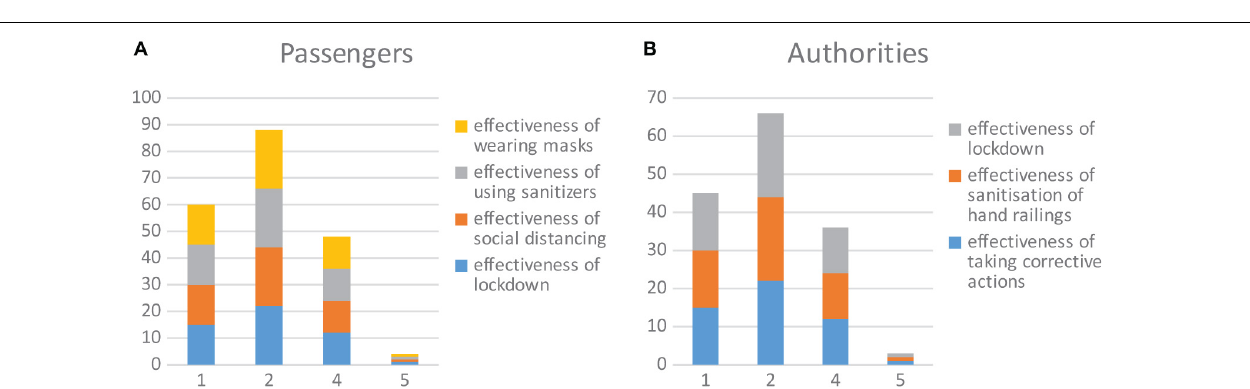
Frontiers in Built Environment |